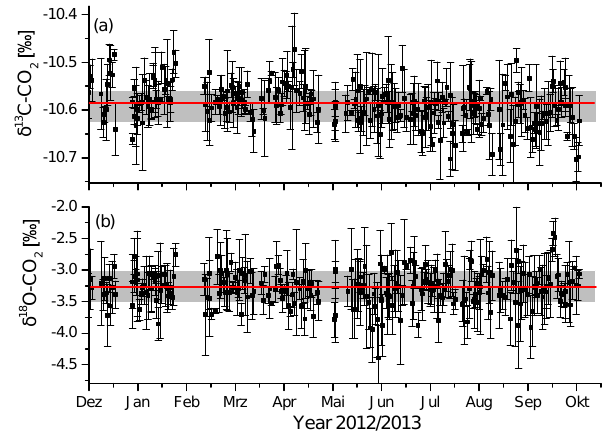
Figure 5. Repeated daily working gas measurements (9min aver- ages) depict an intermediate measurement precision of (a) ± 0.04‰ for δ 13 C-CO 2 and of (b) ± 0.27‰ for δ 18 O-CO 2 (b) for the period from December 2012 to October 2013. Red lines: mean values, grey areas: standard